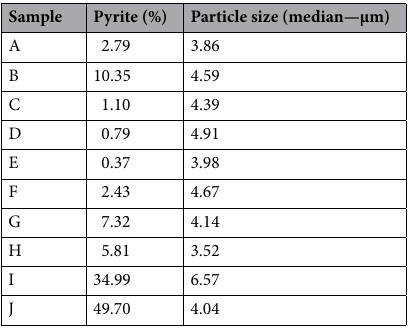
Table 1. Summary of the characteristics of the 10 coal samples used to assess the association between the pyrite content, iron release and the cellular